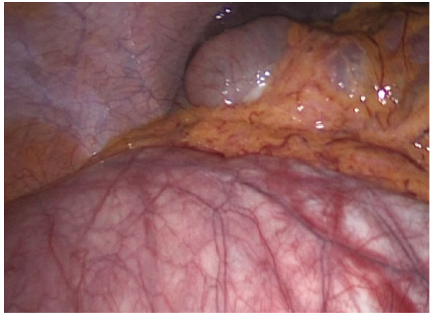
Figure 4: The giant paratubal cyst sac after drainage persistently reaching the upper abdominal structures (the liver and the gall